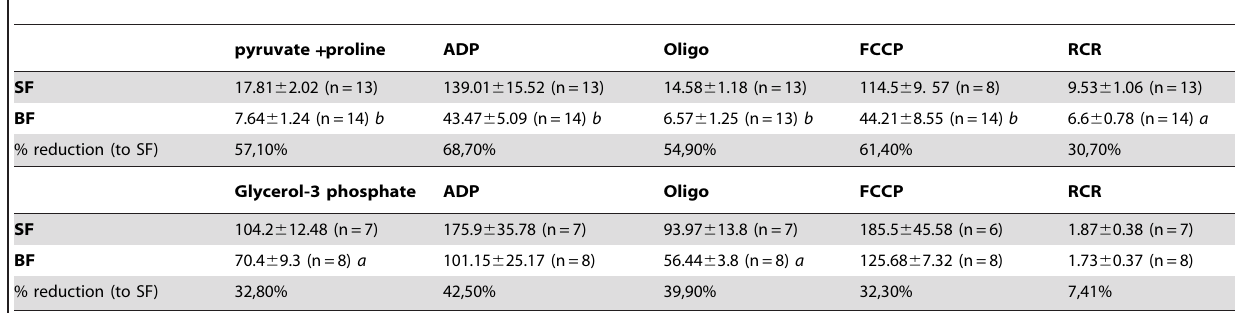
Table 1. Effects of blood-feeding on oxygen consumption rates in different metabolic states in A. aegypti FM